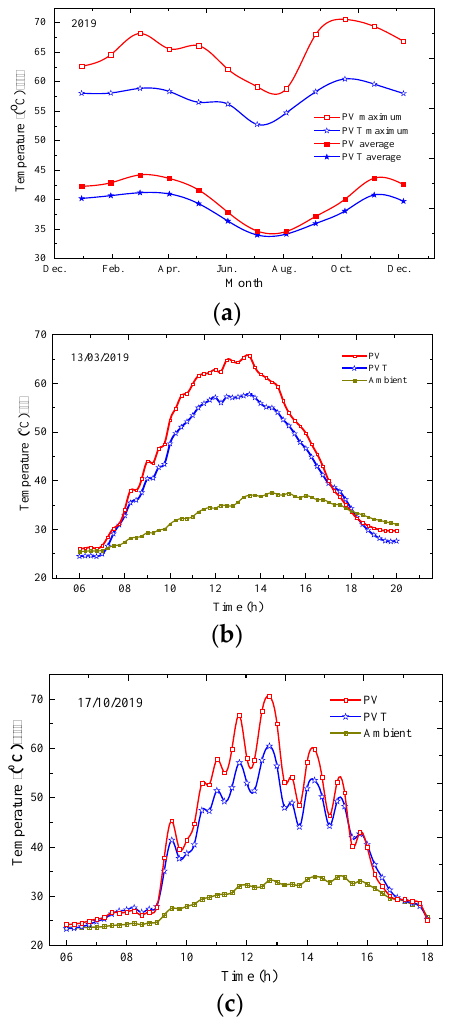
Figure 7. PVT and PV modules temperature profiles at daytime showing variations in: ( a ) monthly average daily temperatures for 2019; ( b ) daily temperature variation on a stable sunny day; ( c ) daily temperature variations on an unstable sunny day. Table 3. A summary of weather data and module